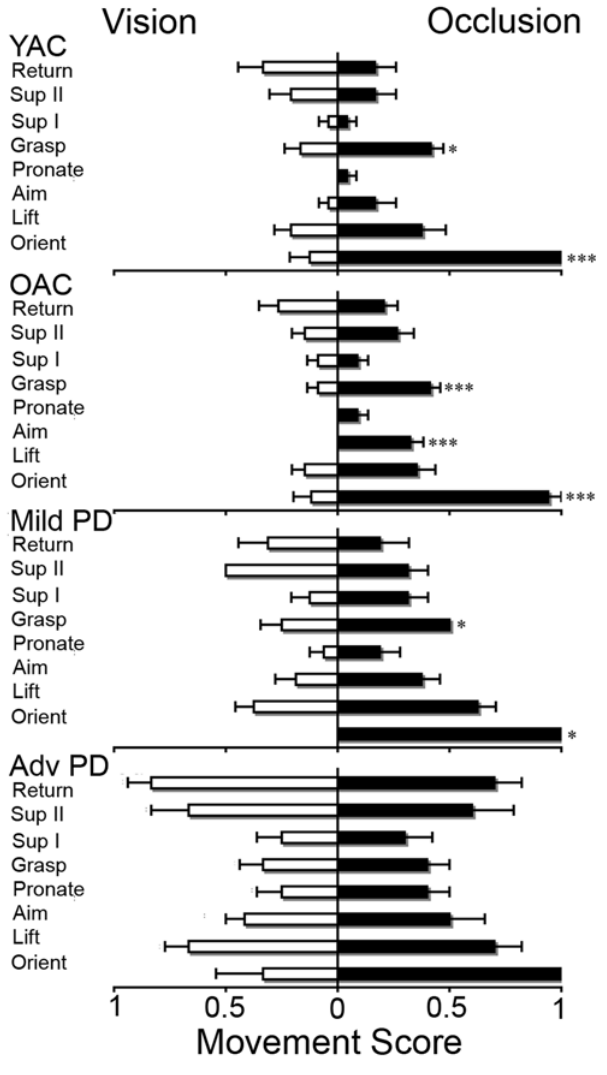
Figure 7. Movement element score (mean and standard error) for vision (left) and occlusion (right). ***=Advanced PD . that other groups; # =Advanced PD . mild PD.